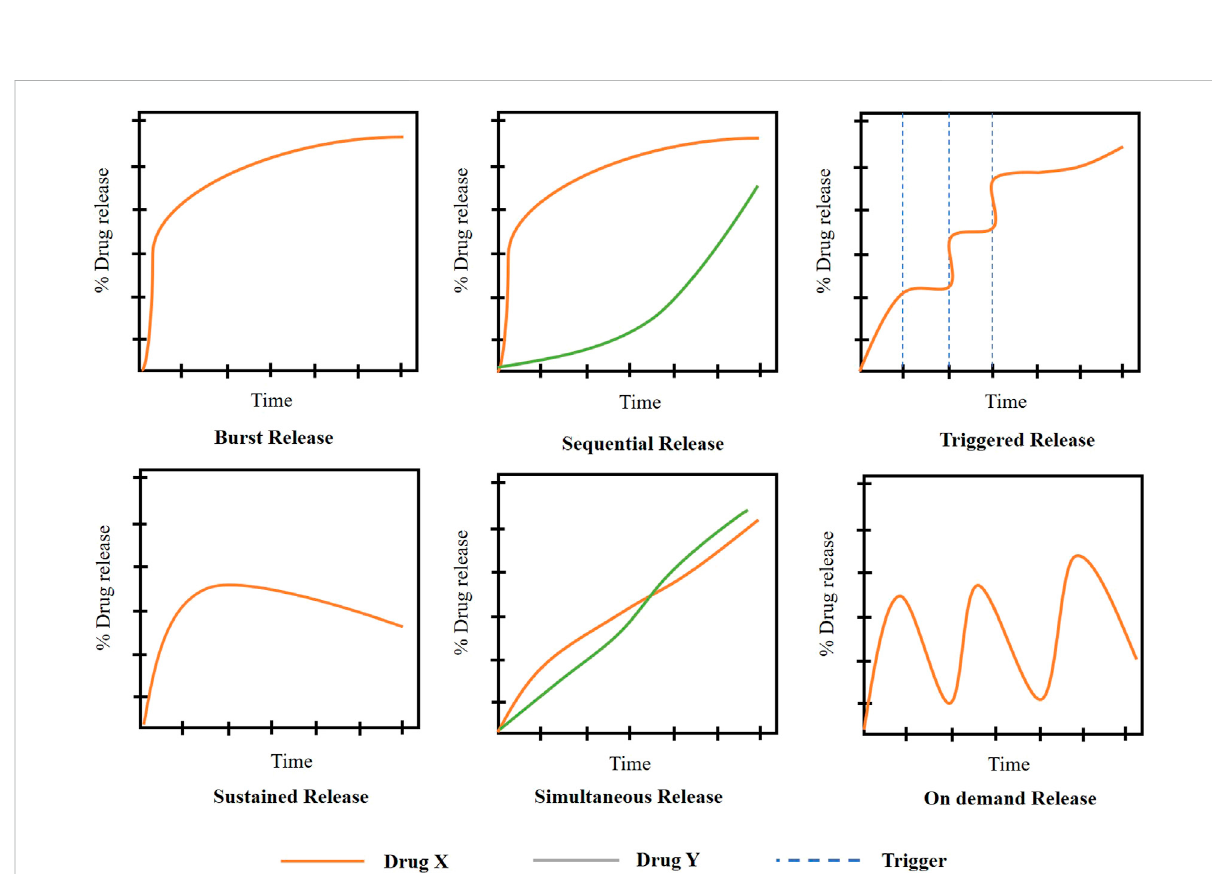
FIGURE 8 Drugreleasemechanismsfromscaffolds((AdaptedwithpermissionfromRef(Rotheetal.,2020;AdepuandRamakrishna,2021)underCreative Commons Attribution License (CC